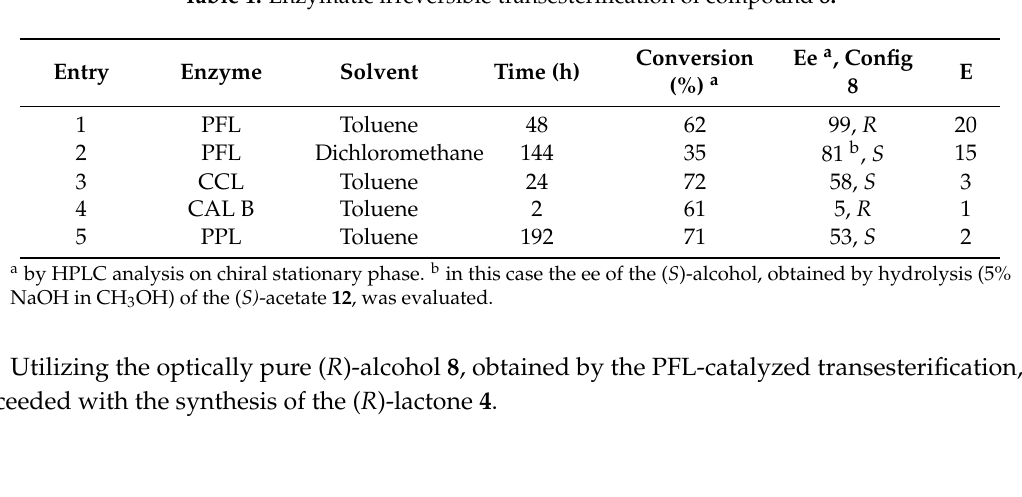
Table 1 . Enzymatic irreversible transesterification of compound 8. Table 1. Enzymatic irreversible transesterification of compound